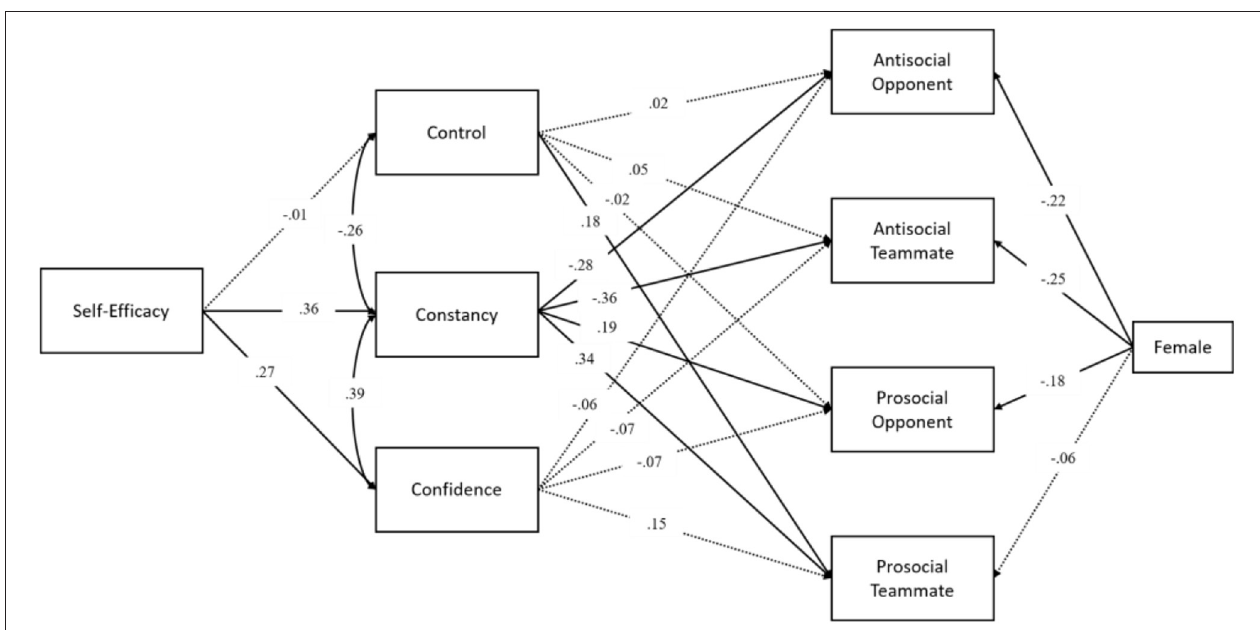
FIGURE 1 | Path diagram and standardized path coefficients for the relationship among self-efficacy, mental toughness, and prosocial and antisocial behavior. Female indicates the dummy coding of gender.